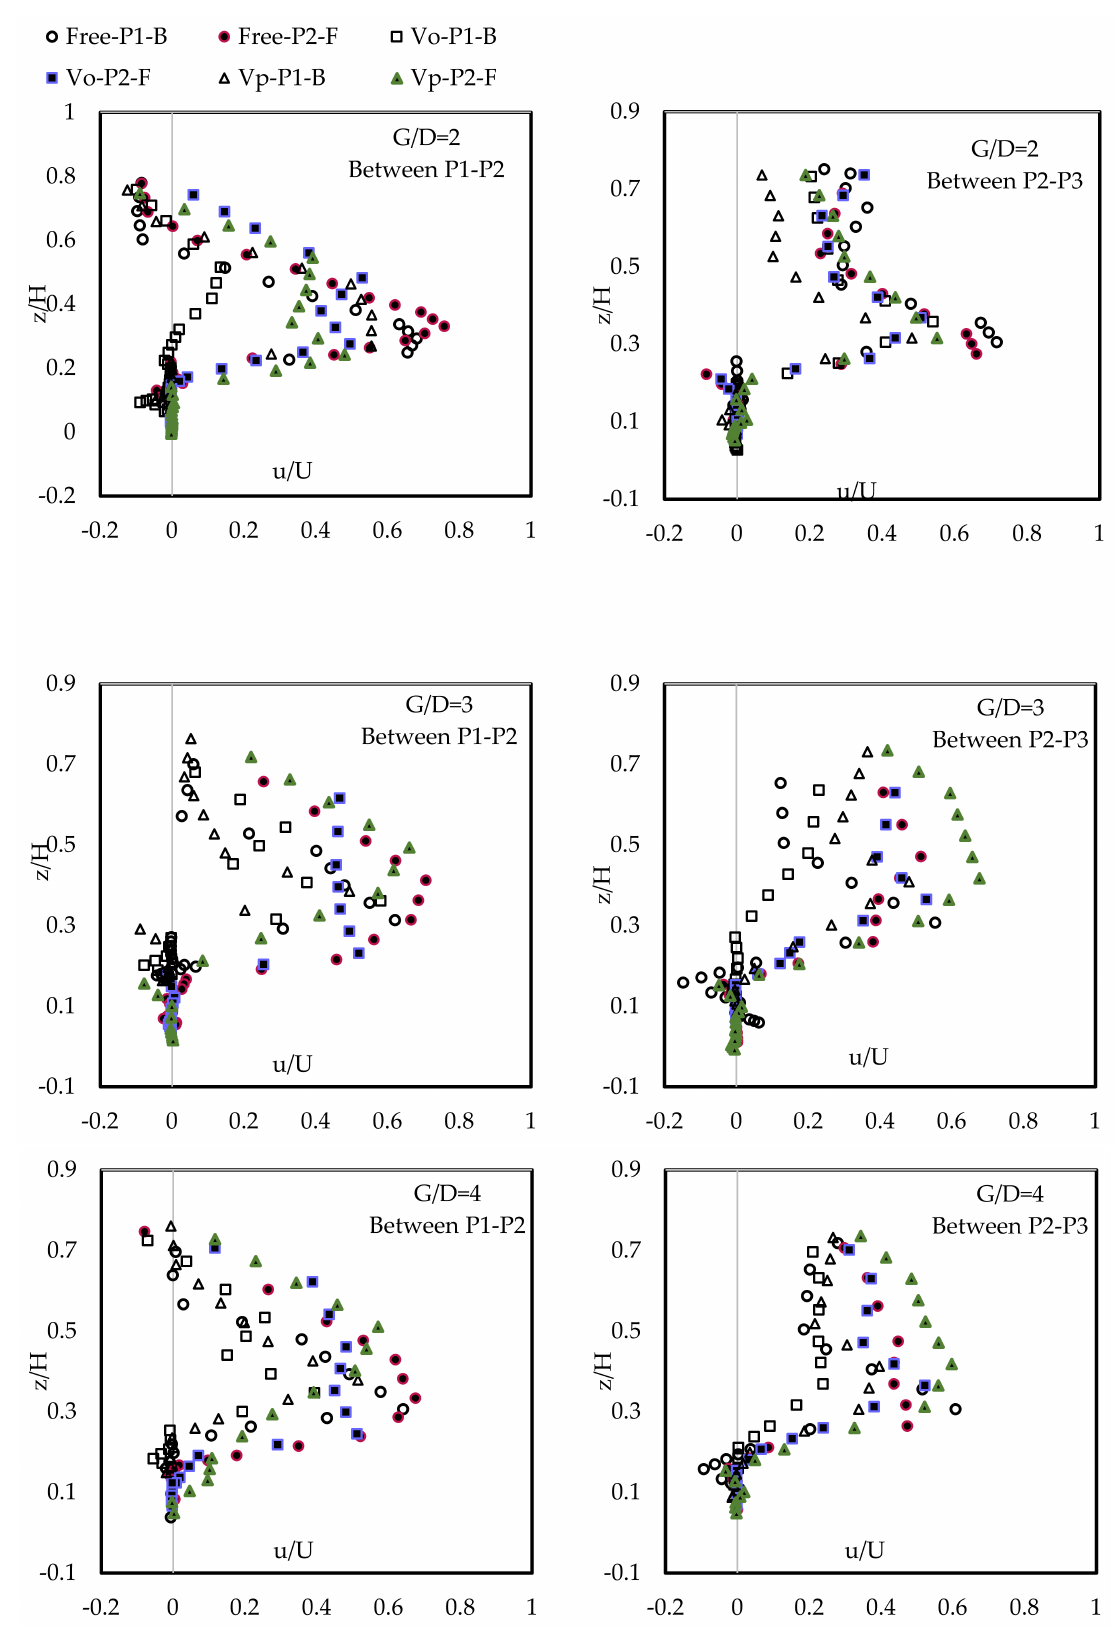
Figure 8. The closest velocity profiles measured between the